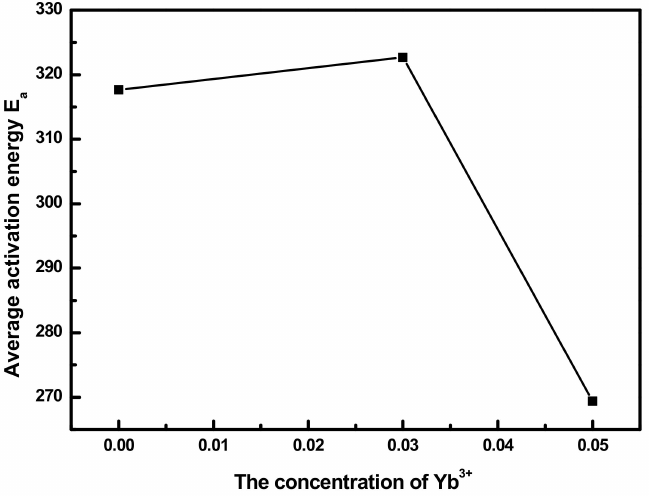
Figure 5. The relationship between the average activation energy and Yb 3+ concentration in Tm 3+ /Yb 3+ co-doped LNT